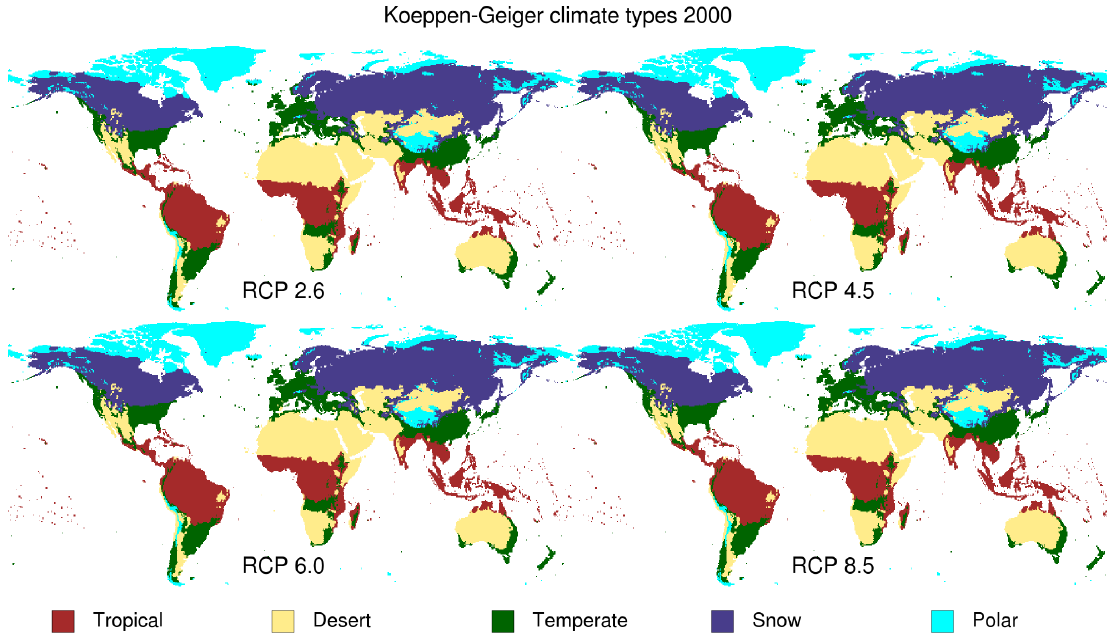
Figure A1. Global map of Köppen–Geiger climate types for 2000.